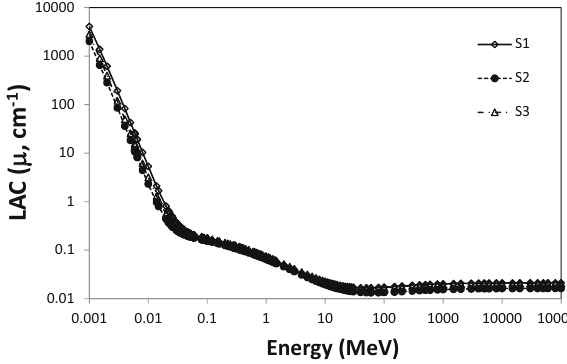
Figure 1: The results of LAC as a function of gamma - ray energies.